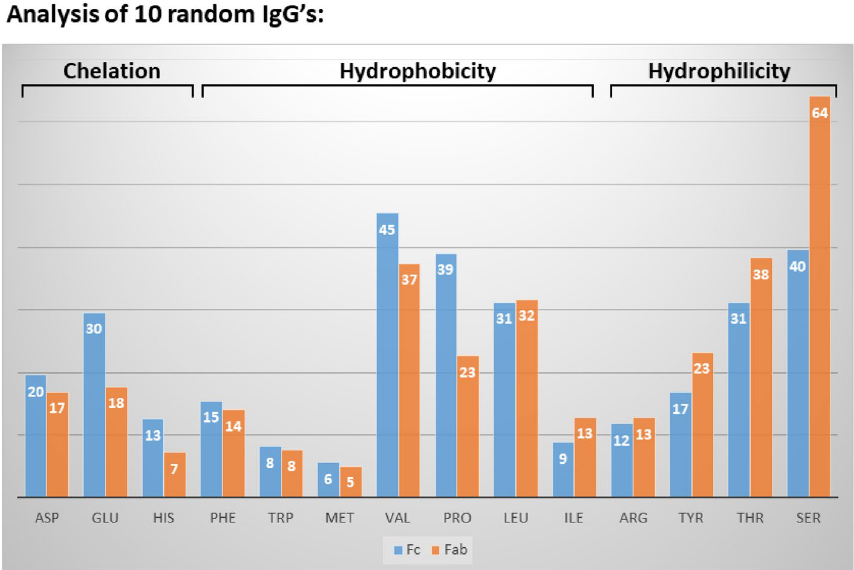
Figure 5. Comparison of amino acid compositions of Fc and Fab domains for 10 randomly chosen IgG’s. Number of amino acids present in either the Fc or Fab domains capable of binding metals (Chelation, LHS); characterized as hydrophobic (center) or hydrophilic (RHS), is indicated. Sequences were retrieved from the UniProt database (https:// www. unipr ot. org/). Values for Trp were rounded off, explaining the differences in bar heights. Additional information regarding these antibody sequences can be found in the Supplementary section (Table